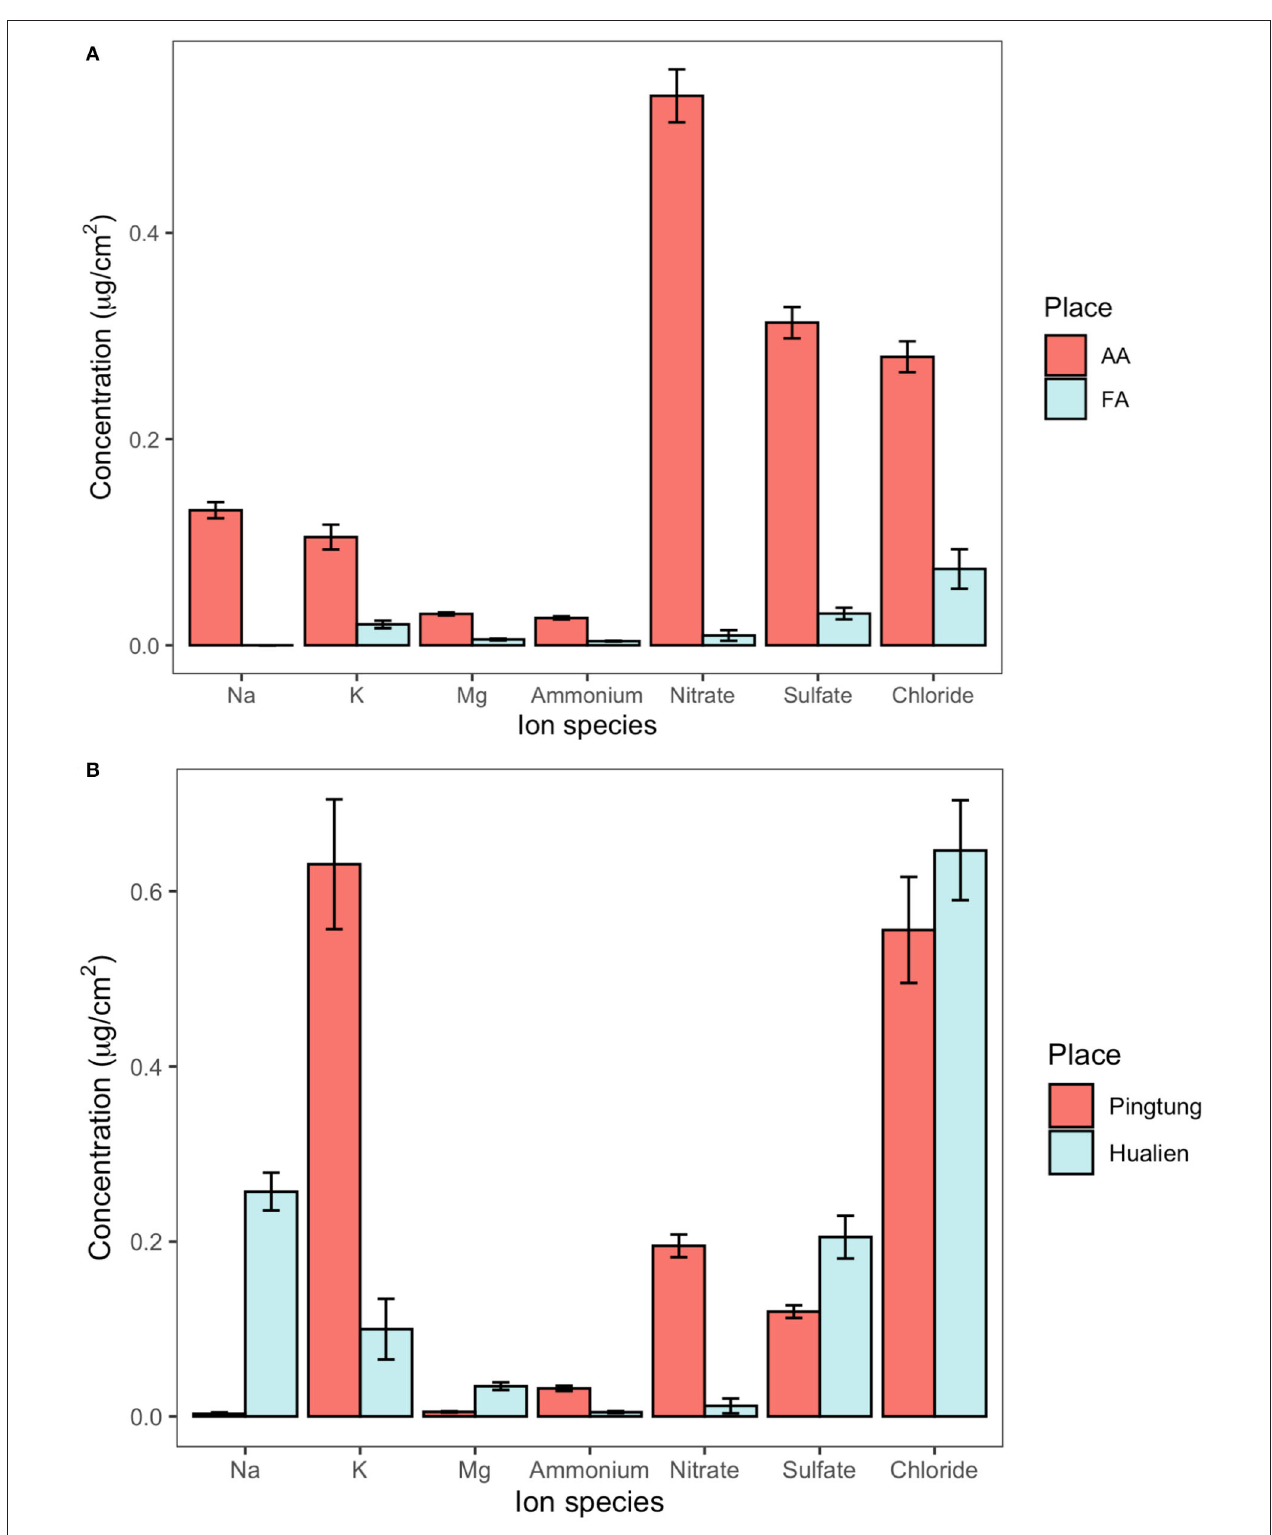
FIGURE 2 | The concentration of dissolvable aerosols deposited on leaf surfaces from greenhouses and fields, determined by foliar rinsing. (A) Ion concentration on camphor leaves from the AA (unfiltered, ambient air) and FA (filtered air) greenhouses. (B) Ion concentration on camphor leaves at Pingtung and Hualien field site.